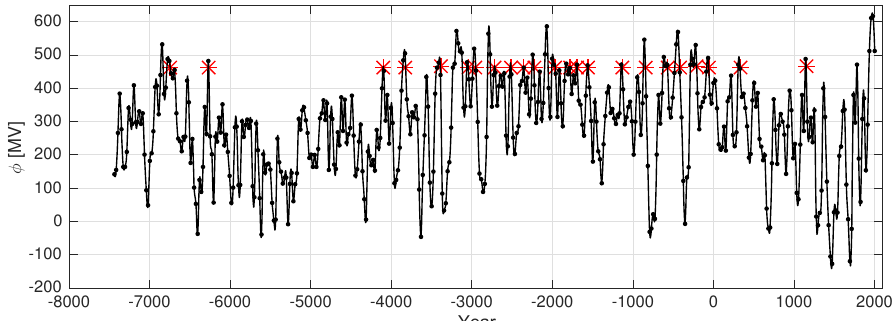
Figure 21. Modulation potential record (cid:56) (MV) used for constructing future scenarios of solar activity. What matters is the relative variation in (cid:56) , which reflects that in the TSI: large values of (cid:56) correspond to grand solar maxima, whereas low values correspond to grand solar minima. Red stars refer to the events used in the analogue forecast; see Sect. 3.1.1. Negative values of the modulation potential are unphysical, but occur in the original record because of our poor knowledge of the cosmic ray spectrum during deep solar